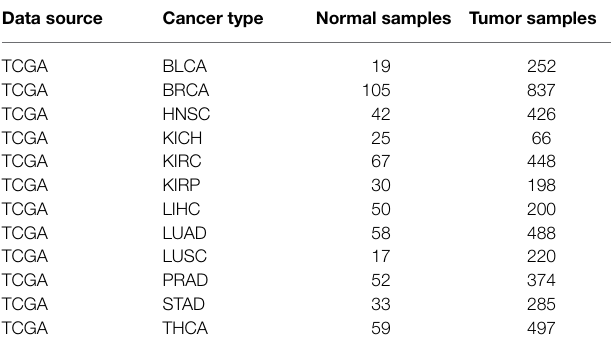
TABLE 1 | LncRNA expression data of 12 cancer types in TANRIC database.